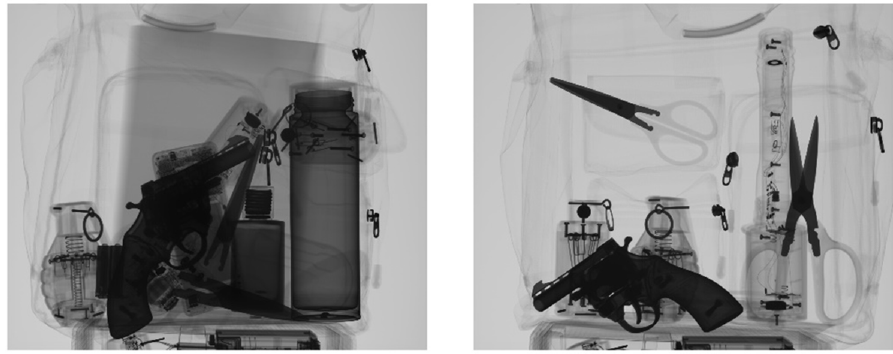
Figure 7. Example images from the GDXray-Expanded dataset.